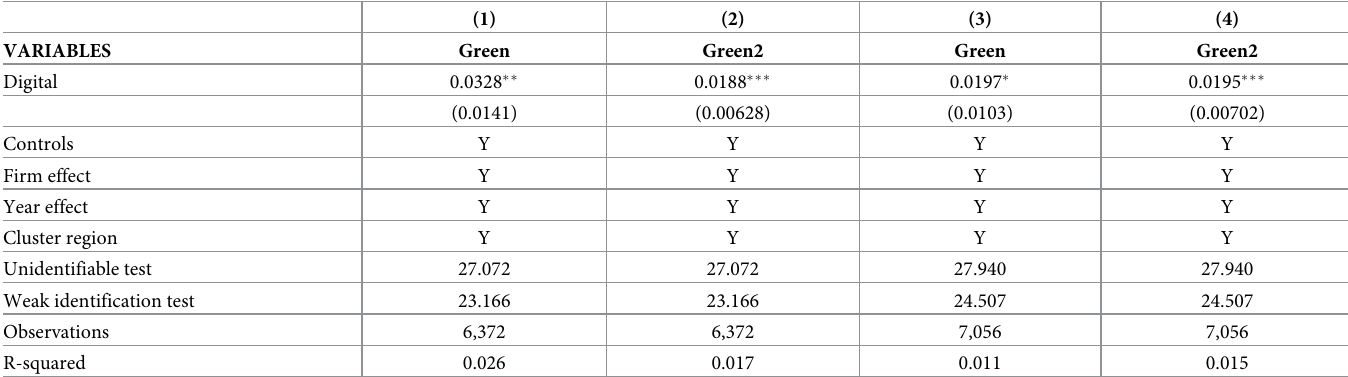
Table 6. Instrumental variable